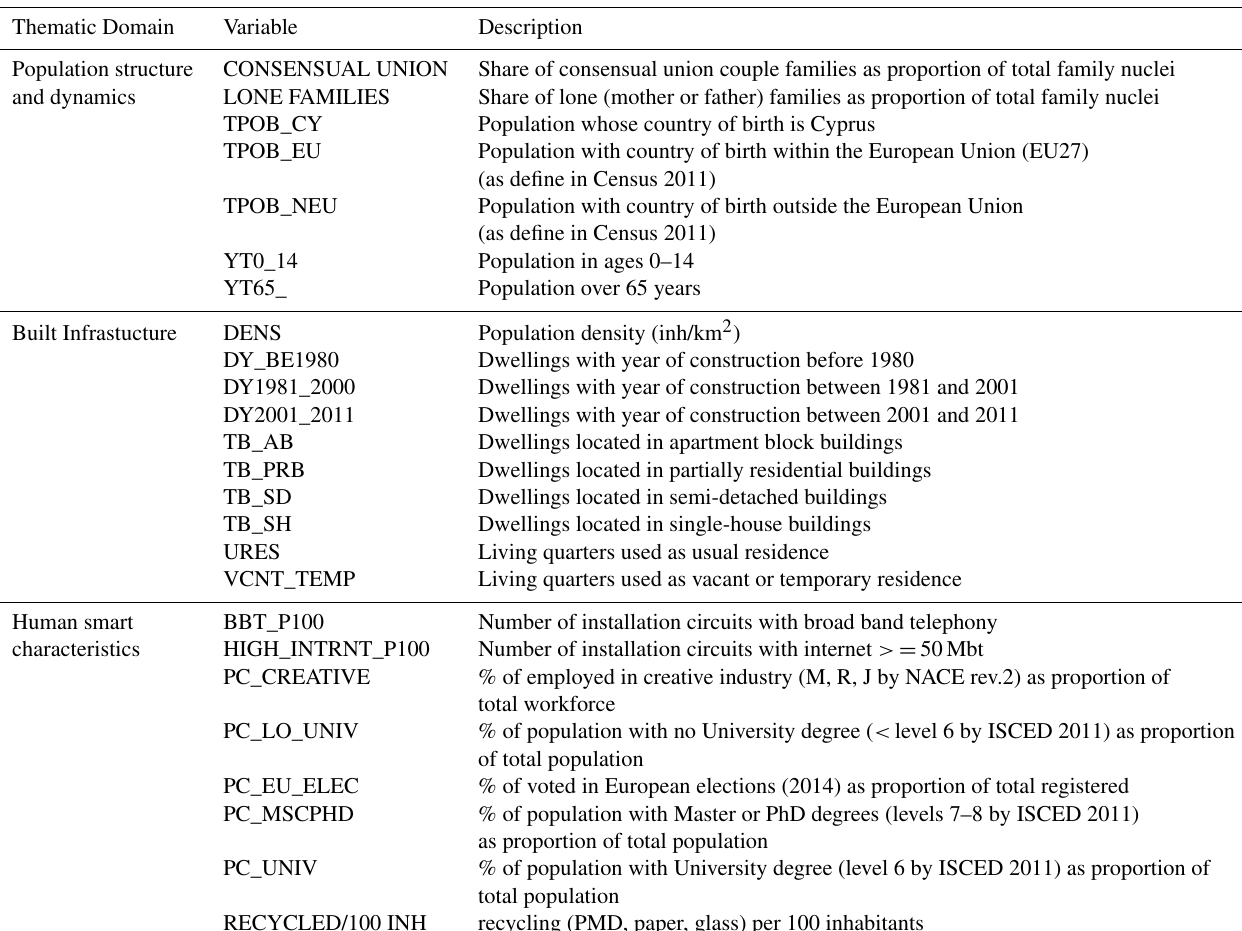
Table 2. Variable categories and description. Thematic